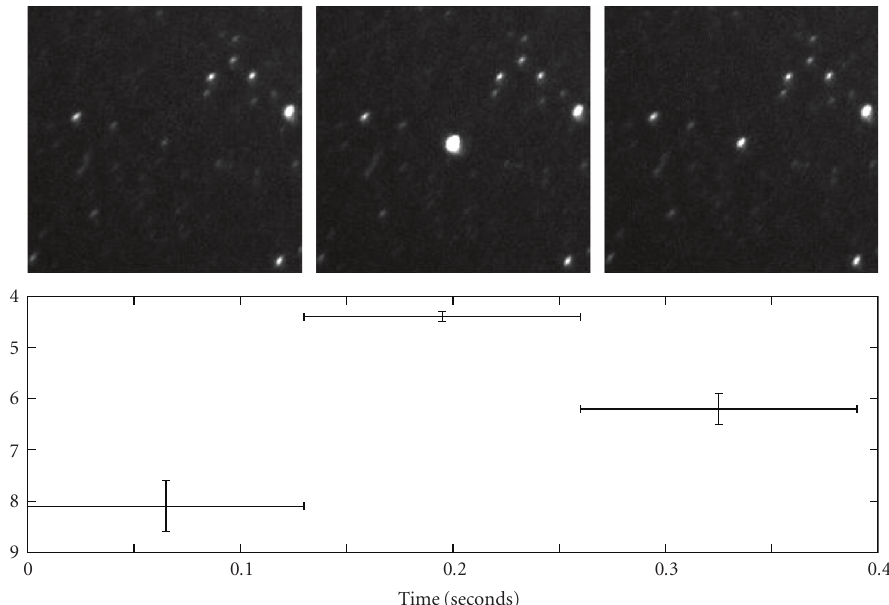
Figure 7: Example of a short flare detected by the FAVOR camera. The total length of the event is 0.4 seconds (seen on 3 successive frames), and the object motion speed is too low to be detected. This is identified as a satellite event by checking the database of satellite orbital parameters.